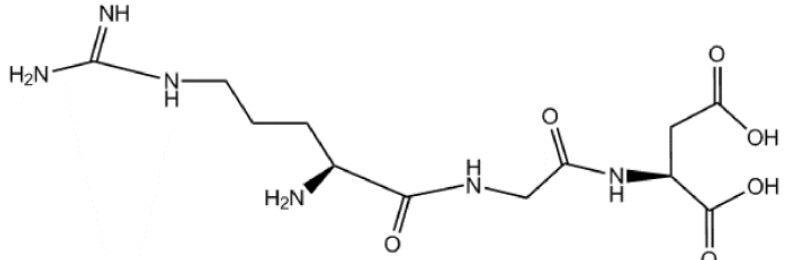
Figure 1. The arginine-glycine-aspartic sequence